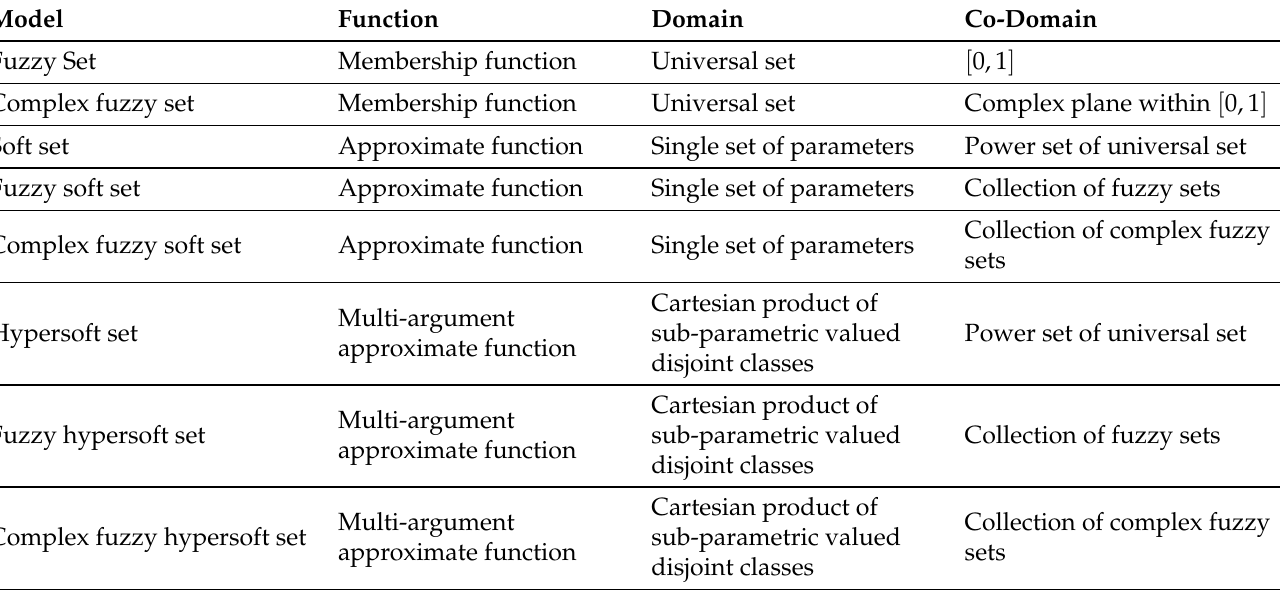
Table 1. Comparison of employed membership function with other membership functions.